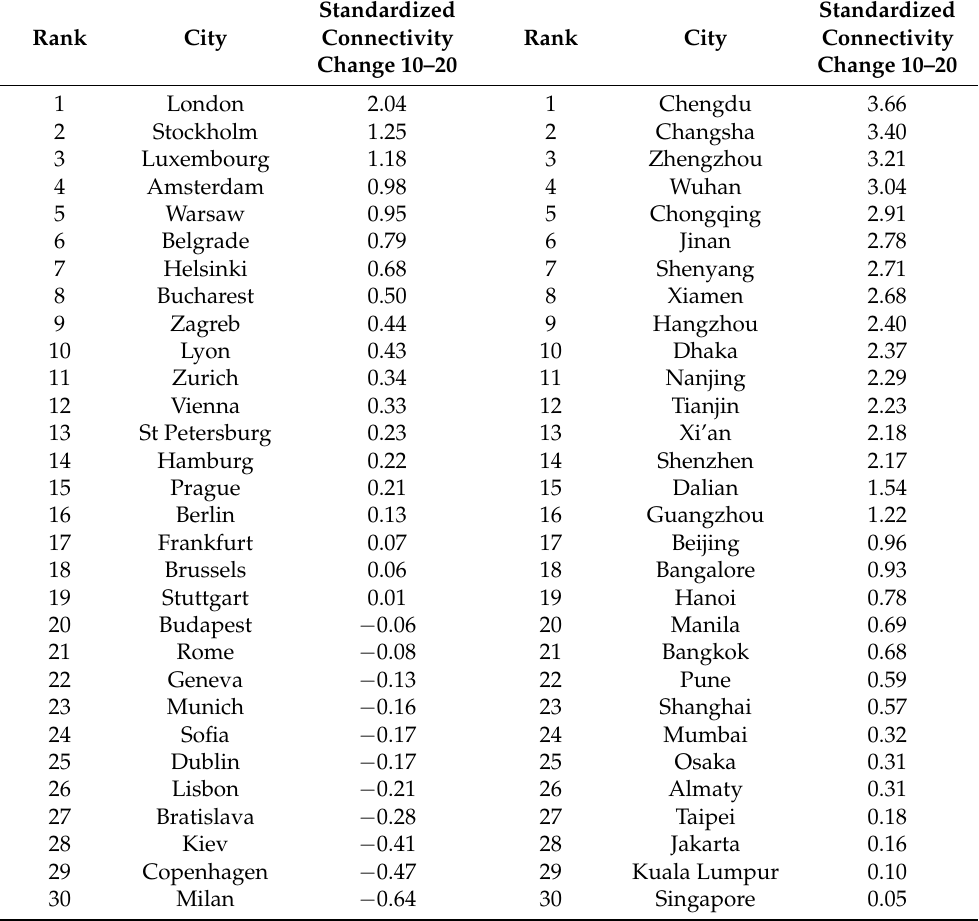
Table 3. Cities rank-ordered by their CCa between 2010 and 2020. Rank City